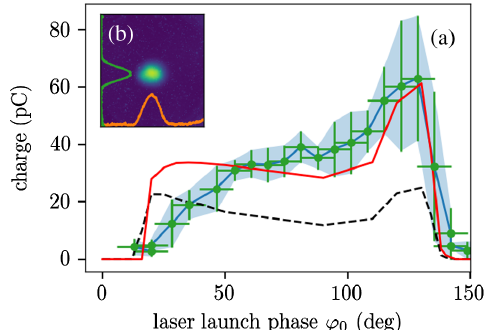
FIG. 3. Measured bunch charge as a function of laser-launch phase (circles with shaded area giving the uncertainty) compared with ASTRA simulations with (solid line, Schottky-strength parameter set to ξ ¼ 2 × 10 − 3 ) and without (dash line, ξ ¼ 0 ) including the Schottky effect. The inset (b) gives the transverse beam distribution on a 10 × 10 mm 2 area at X1 for φ 0 ≃ 95 ° with associated projections (solid